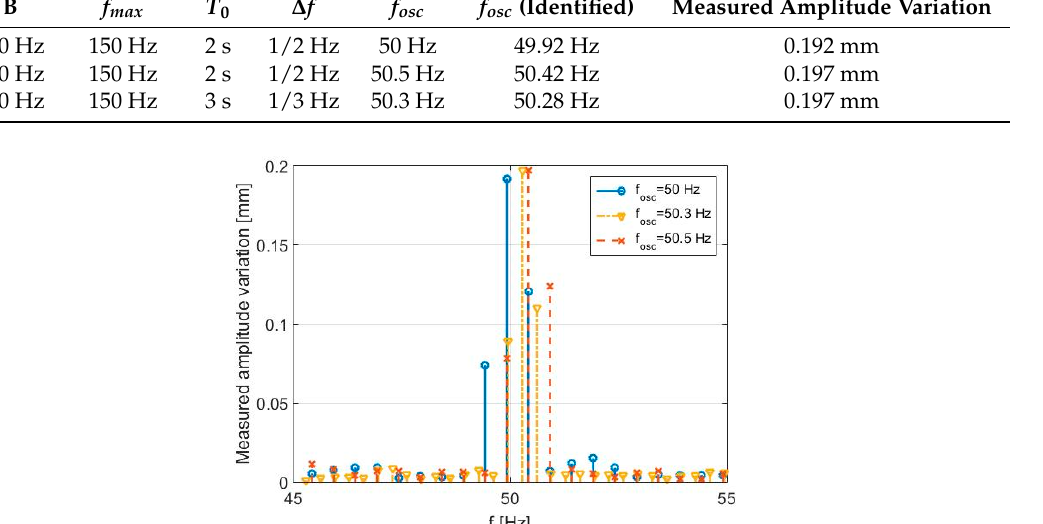
Figure 13. Parameters and results of the first experimental validation test (second test).